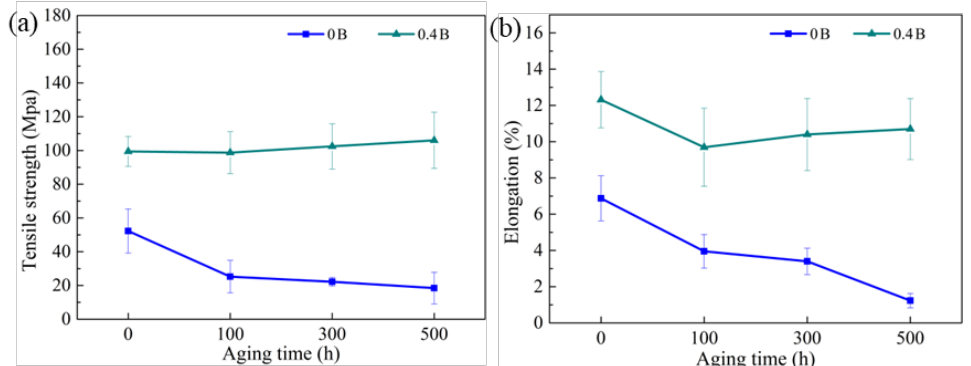
Figure 9. ( a ) Tensile strength and ( b ) elongation of porous Fe20Cr5Al alloy modified with 0.4wt.% B after aging for different times.